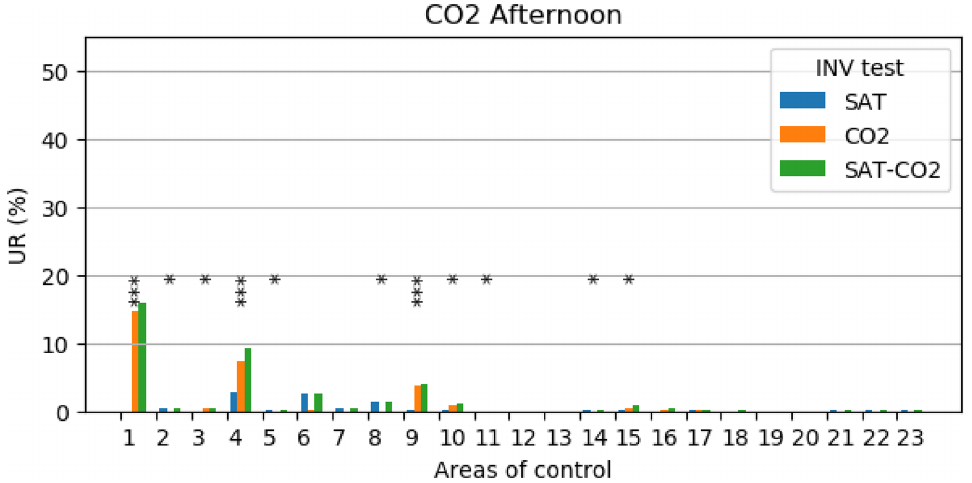
Figure A4. Uncertainty reduction in INV-SAT, INV-CO2, and INV-SAT-CO2 inversions for afternoon budgets of FF emissions of each controlled area in the main area of interest. The number of stars indicates the number of stations in each controlled area. The names of the controlled areas are listed in Table